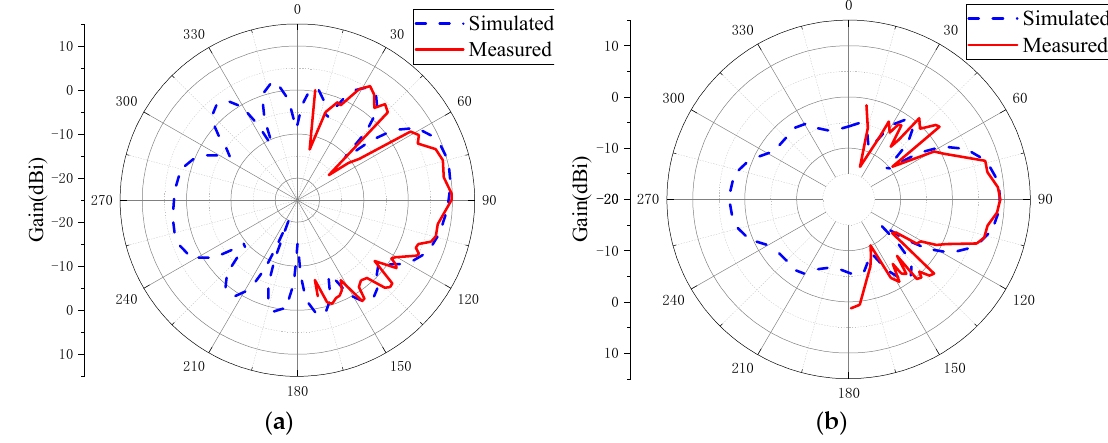
Figure 11. Measured and simulated radiation patterns of the proposed antenna at frequency of 6 GHz: ( a ) elevation plane (EL plane); ( b ) azimuth plane (AZ plane).